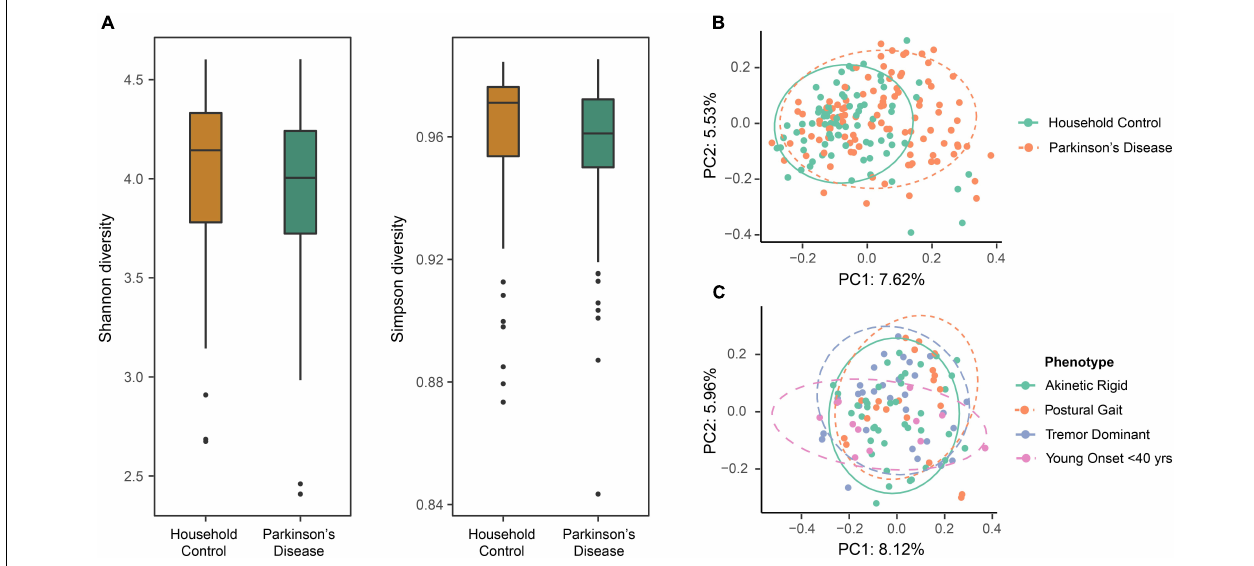
FIGURE 1 | The evaluation of diversity measures between the household control (HC) and Parkinson’s disease (PD) groups identified differences in beta diversity measures but not alpha diversity. (A) Box plots representing alpha diversity showed no significant differences in Shannon (species abundance and evenness within a community) or Simpson (species richness and evenness within a community) diversity between the HC and PD cohorts (ANOVA, p = 0.057 and 0.159, respectively). (B) Beta diversity using principal coordinate analysis (PCoA) with Bray-Curtis dissimilarity at amplicon sequence variant (ASV) level. Comparison of the first two principal components revealed varied beta diversity (extent of species diversity difference between two environments) between the groups (PERMANOVA, p < 0.0001), suggestive of a disease-related effect on GM composition that might define a PD-related GM profile. Colored ellipses (solid green = HC and dotted orange = PD) represent a 90% confidence region and the proportion of total variance represented by a given principal component is labeled on the respective axis. (C) Evaluating the effects of PD phenotypes in terms of gut microbial beta diversity showed no overall statistical significance between the four groups (PERMANOVA, p = 0.112). Although, the greatest diversity difference was seen for the younger onset < 40 years subgroup, as compared to the tremor dominant, akinetic rigid and postural instability